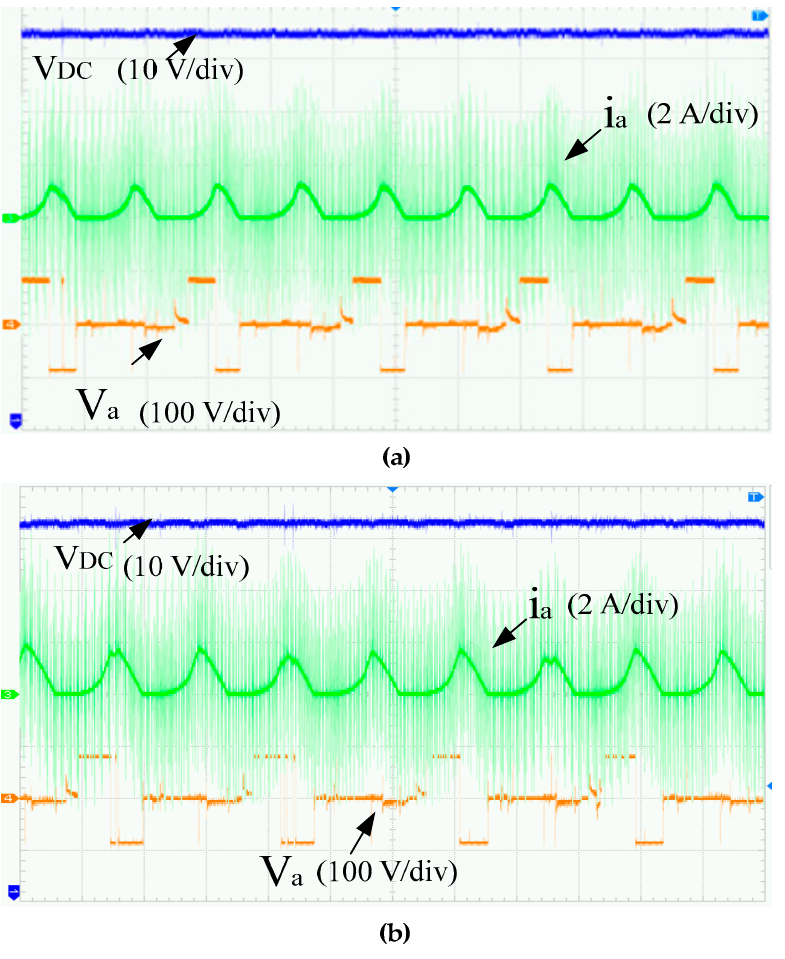
Figure 16. Experimental waveforms at 1000 rpm of two controllers of the SRG power system: ( a ) PI control; ( b ) PR control.